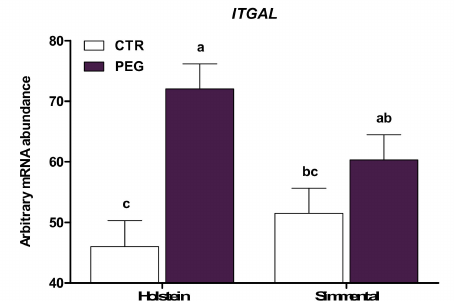
Figure 1. LSM ± SEM of arbitrary mRNA abundance for gene expression of ITGAL (integrin subunit alpha L) evaluated three days after calving in Simmental and Holstein cows treated either with pegbovigrastim (PEG) or with saline (CTR) at approximately Day 7 relative to calving and on the day of calving within 24 h. Di ff erent letters represent significant di ff erences among groups at p ≤ 0.05.